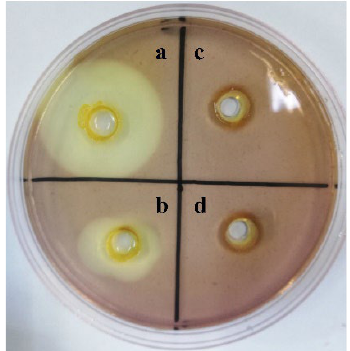
Figure 1. Screening results of κ -carrageenan degradation effect. ( a ): intracellular enzyme; ( b ) extracellular enzyme; ( c ): bovine serum protein; ( d ): PBS